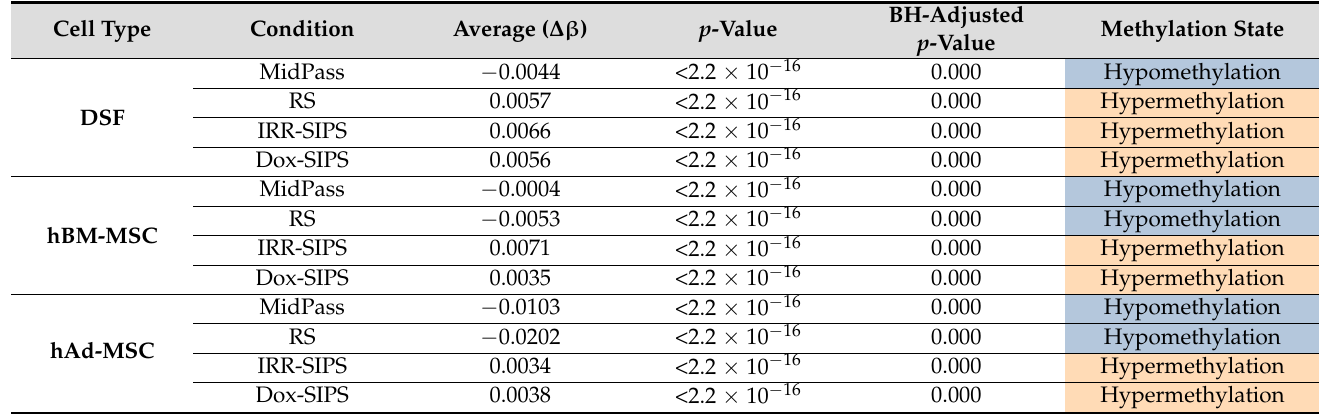
Table 1. Global methylation levels found in particular cell types under different conditions. Respec- tive early-passage cultures were used as the reference.